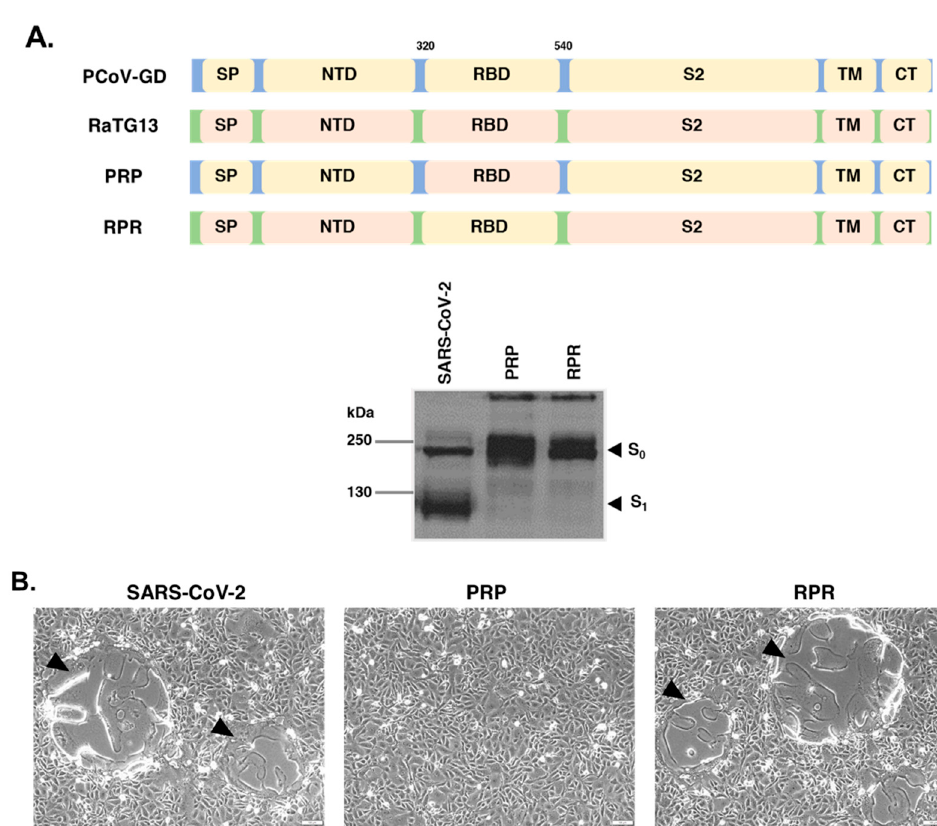
Figure 2. The inability of RaTG13 to undergo cell–cell fusion with VeroE6 cells is due to its RBD. ( A ). Schematic illustration of chimeric spike constructs in which the RBD of RaTG13 was swapped with that of PCoV-GD (PRP) and the RBD of PCoV-GD was swapped with that of RaTG13 (RPR). Using antibodies specific for the SARS-CoV-2 spike, the expression of the two chimeric constructs was evaluated using Western blot. Arrows indicate the unprocessed spike (S0) and the cleaved spike product (S1). ( B ). Cell–cell fusion in the presence of trypsin in VeroE6 cells transfected with each chimeric spike construct. At 24 h after transfection, images were captured using an inverted light microscope (scale bars of 100 µ m). The black arrows indicate areas where cell–cell fusion was